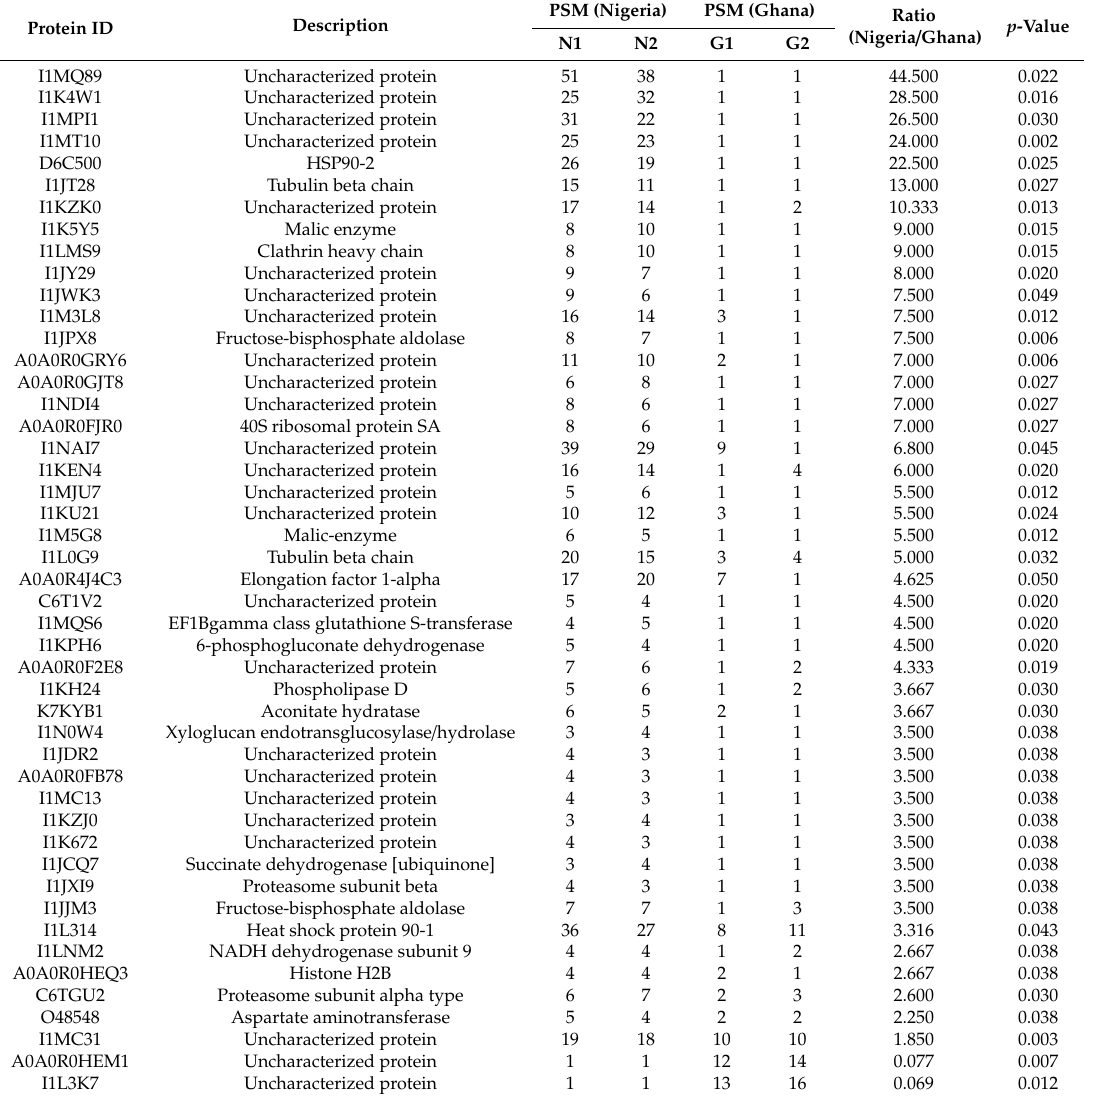
Table 1. The significantly changed proteins between the seeds of X. aethiopica from Ghana and Nigeria. Protein